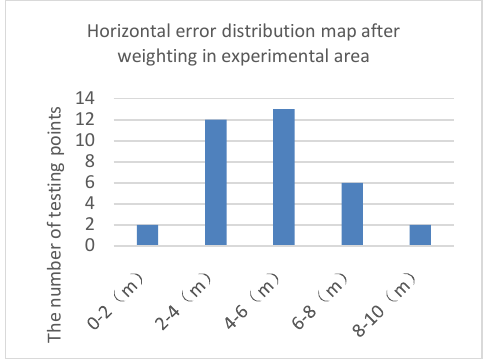
Figure 1. Horizontal error distribution map